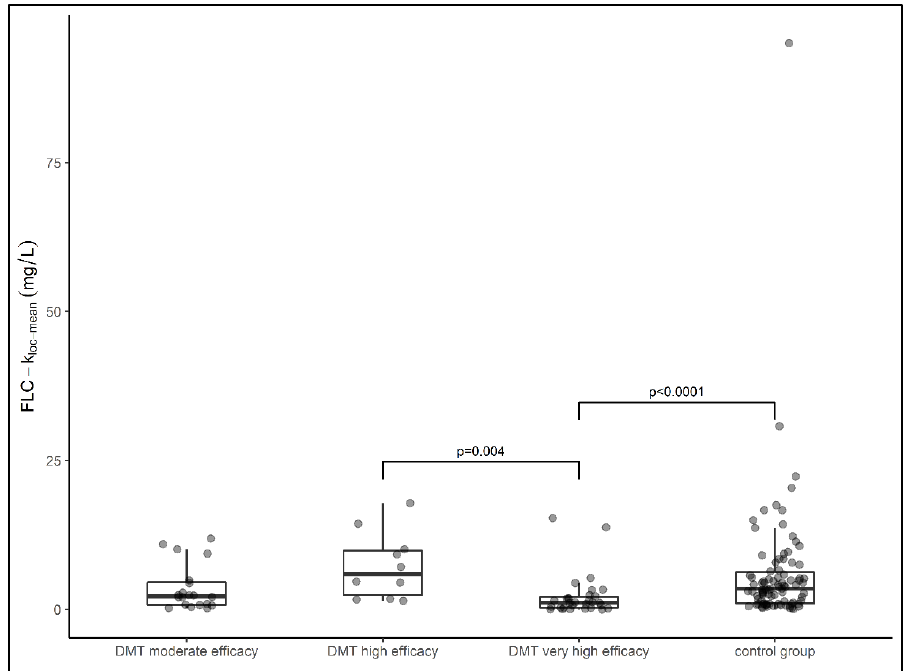
Figure 1. Data on local IgG concentrations of patient samples presented in box plots (median, first, and third quartile). Samples from patients treated with very highly effective DMT had significantly lower IgG concentrations than samples treated with highly effective DMT ( p = 0.013) and the control group ( p = 0.021). DMT—disease-modifying therapy, Ig—Immunoglobulin . Comparison between groups was performed using the Kruskal–Wallis test. The Dunn–Bonferroni test was used for post hoc analysis .